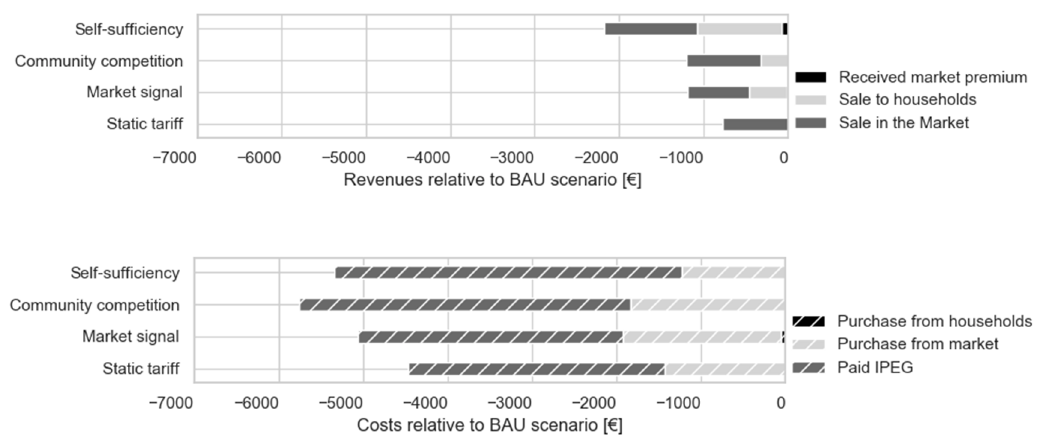
Figure 9. Retailer’s cost and revenue streams relative to the BAU scenario; negative values show the reduction of each stream relative to the corresponding stream in the BAU scenario.